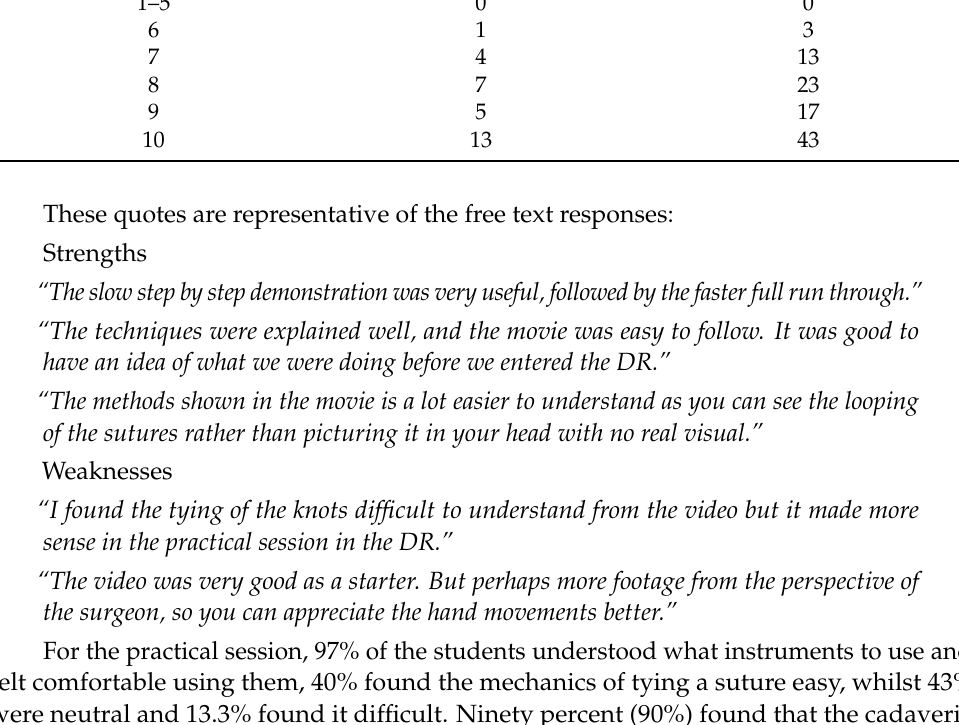
Table 3. How useful the students ( n = 30) found the movie for their learning on a scale of 1 to 10. Score No of Respondents % Respondents 1–5 0